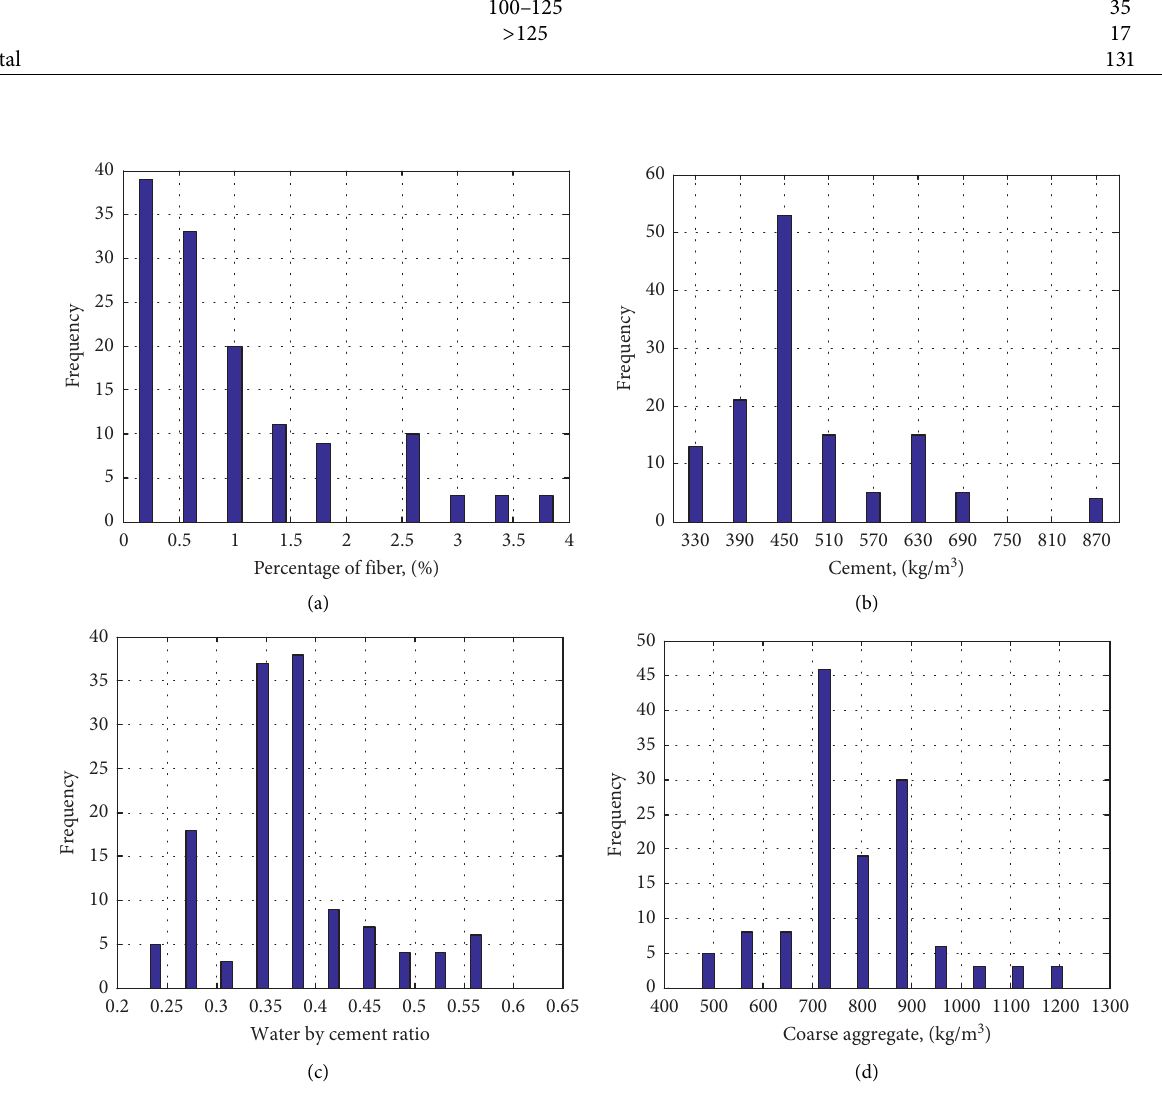
Figure 1: Distribution of four selected input